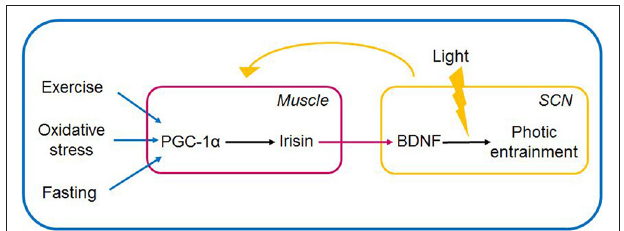
FIGURE 4 | Muscle-brain crosstalk: irisin (via PGC1- α ) serves as link between peripheral non-photic entrainment signals (fast, cold, exercise) and light-induced signalization in the SCN. Irisin is induced and released in the periphery, and upon its entering the hypothalamus is hypothesized to induce BDNF expression and release. BDNF by its permissive effect is able to gate the signalization in the SCN if light signal provided. The SCN in turn entrains peripheral organs via neurohumoral, hormonal, temperature, and other indirect signals. The link between irisin and BDNF in the SCN is hypothetical. BDNF, brain-derived neurotrophic factor; PGC-1 α , peroxisome proliferator-activated receptor γ coactivator 1 α ; SCN, suprachiasmatic